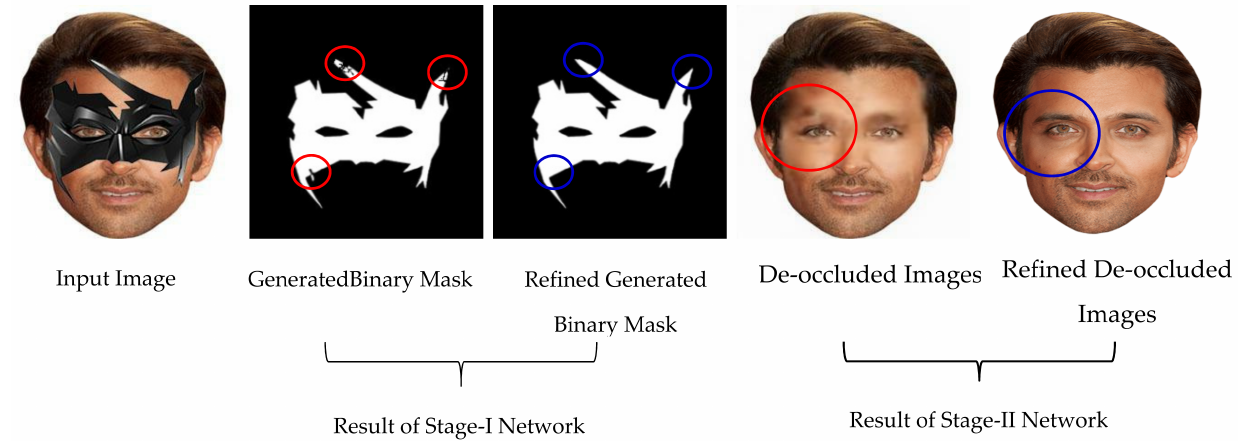
Figure 9. Results of image refiner network on real-world images further improve the results by rectifying what is missing or wrong in the mask base network